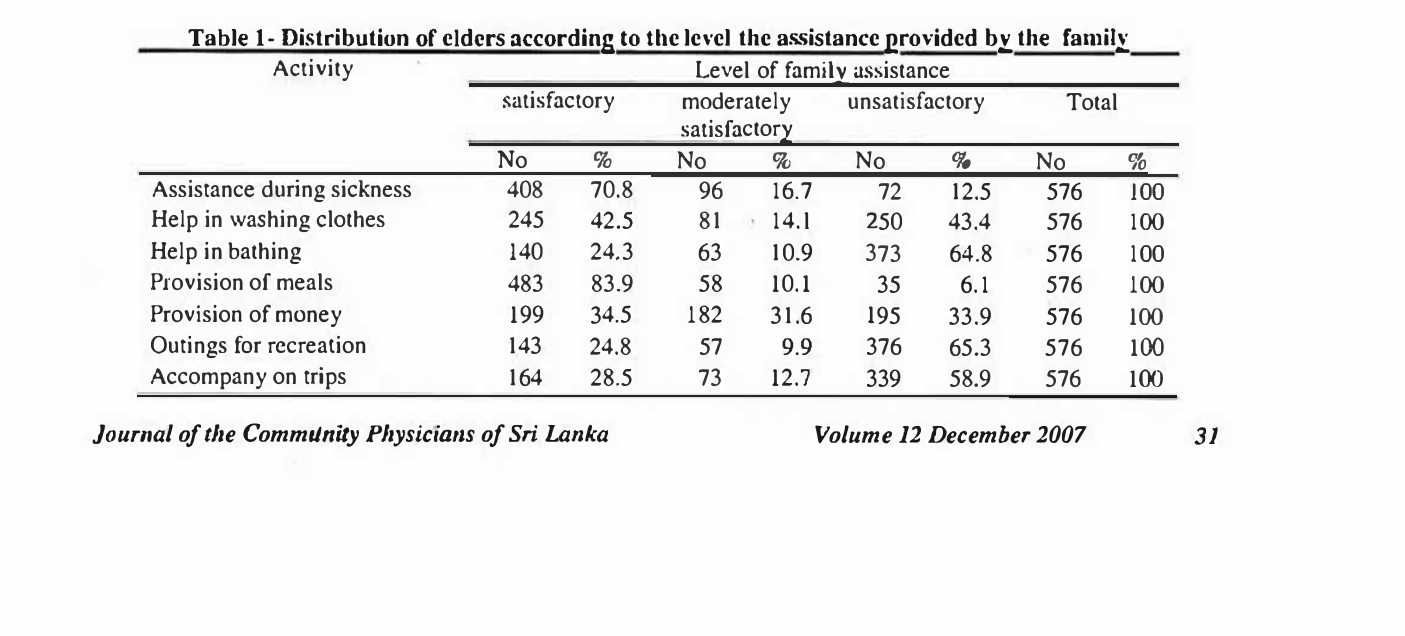
Table 1-Distribution of elders according to the level the assistance Erovided b,l:'. the famill'.